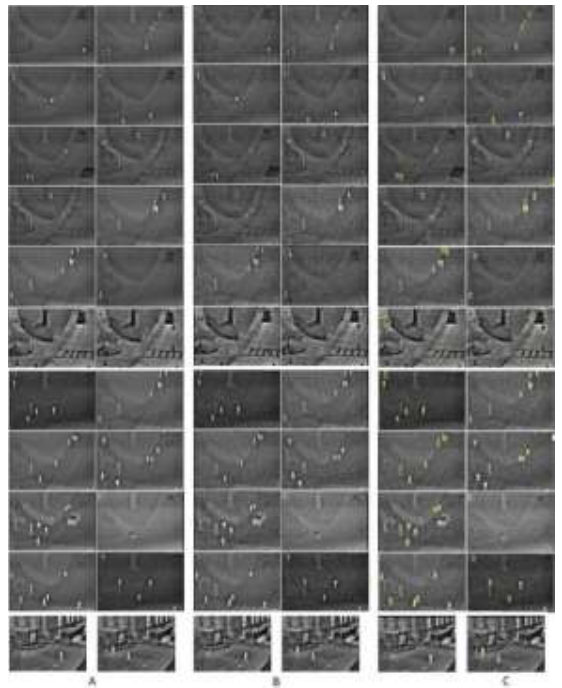
Figure 31. Samples of pedestrians' detection in noisy images (A: input images, B: noisy images, C: pedestrian